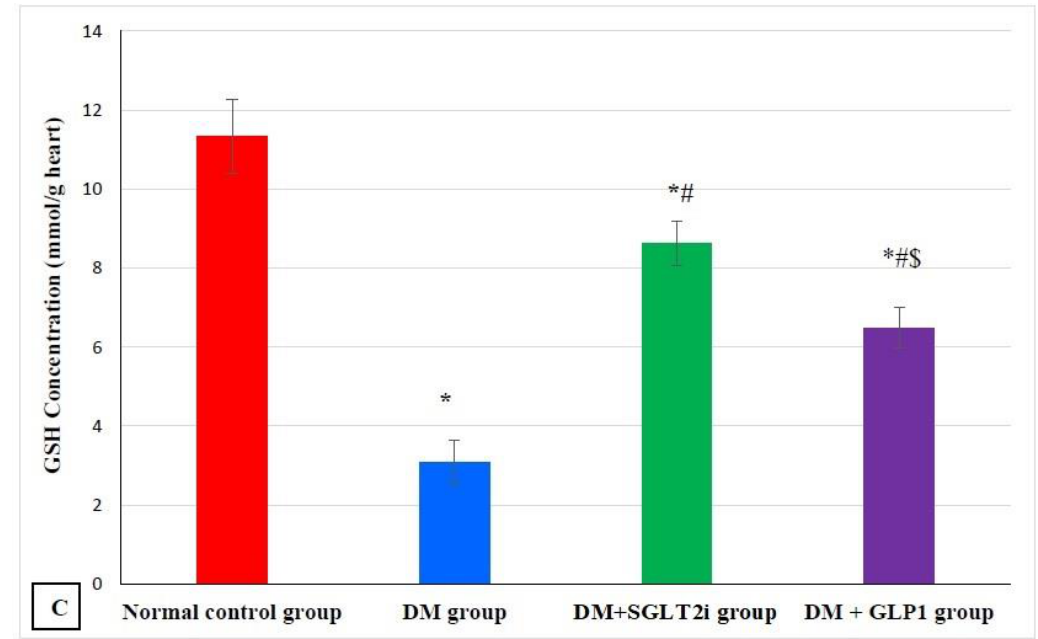
Figure 1. Myocardial oxidative stress markers in different groups. ( A ) Malondialdehyde (MDA) concentration (nmol/g heart tissues), ( B ) catalase enzyme activity (U/g heart tissues) and ( C ) reduced glutathione (GSH) concentration (mmol/g heart tissues). * Significant vs control group, # significant vs DM group, and $ significant vs DM+ SGLT2i group.